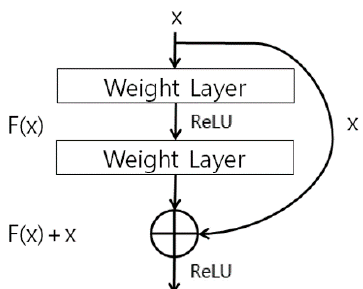
Figure 7. Shortcut for residual learning in ResNet. ReLU means rectified linear unit layer.